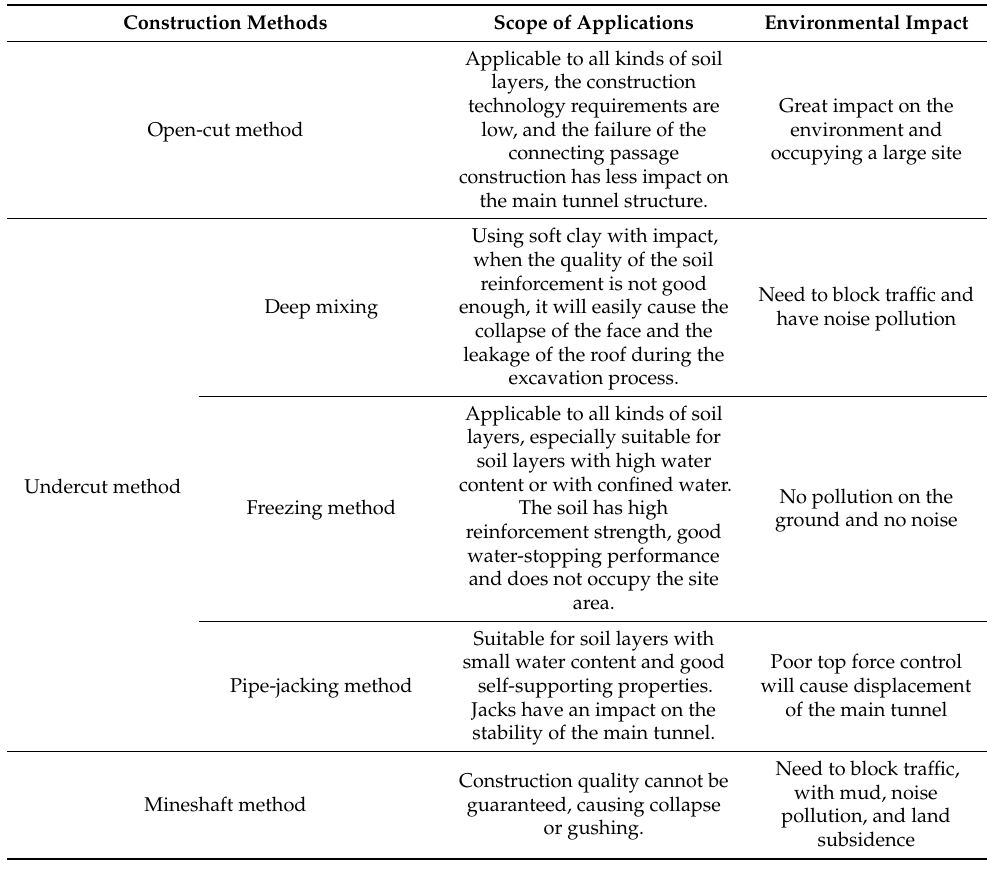
Table 1. Comparison of common construction methods for connecting passages of metro